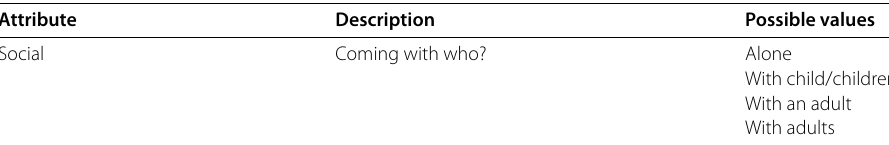
Table 4 Social attributes of questionnaire data Attribute Description Possible values Social Coming with who? Alone